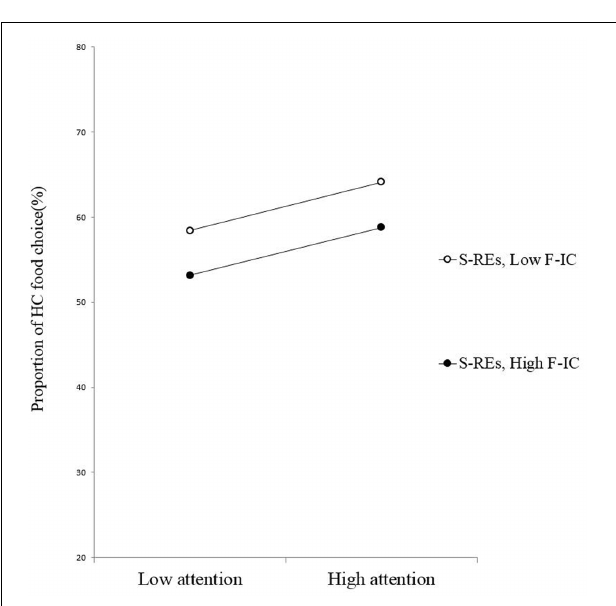
FIGURE 4 | Slopes for the automatic attention–food choice relationship across levels of F-IC among the